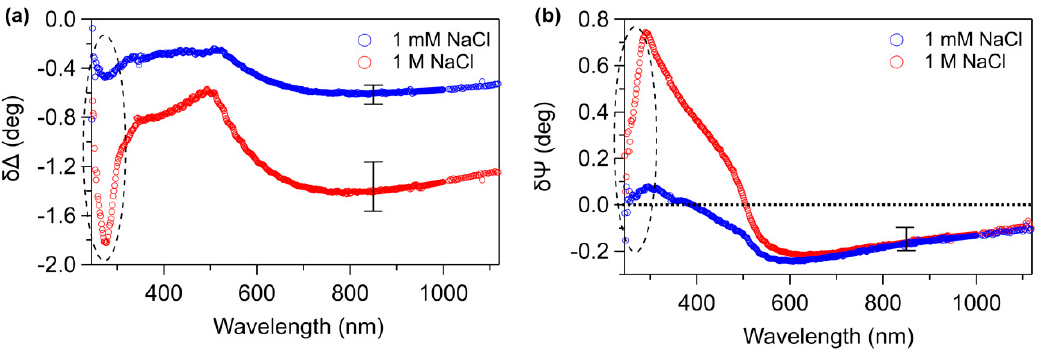
Figure 4. ( a ) δ ∆ and ( b ) δ Ψ spectra of 1 mM NaCl C 6 -ssDNA (blue curve) and 1 M NaCl C 6 -ssDNA (red curve). Error bars take into account the sample to sample variability. Dashed regions indicate fingerprint dips related to 260 nm DNA absorption.